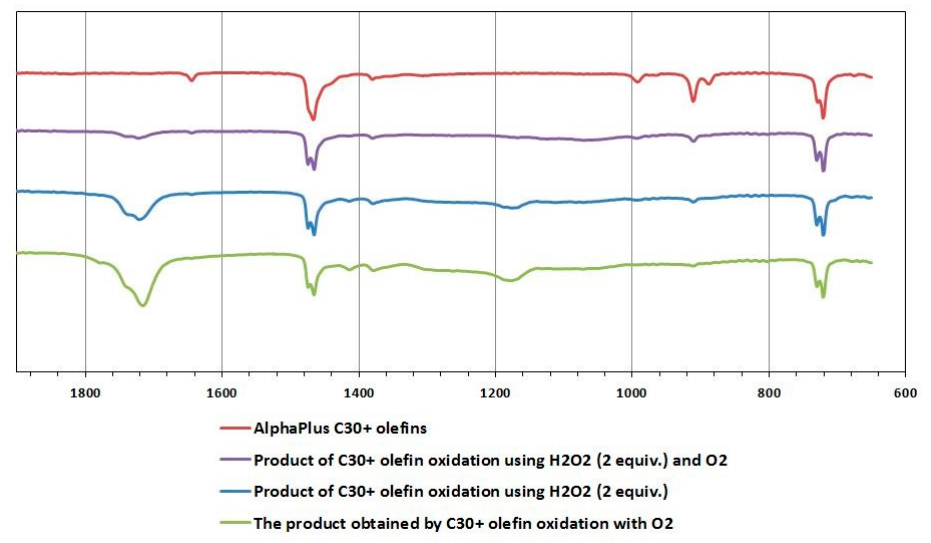
Figure 6. Comparison of FT-IR spectra of oxidation products.